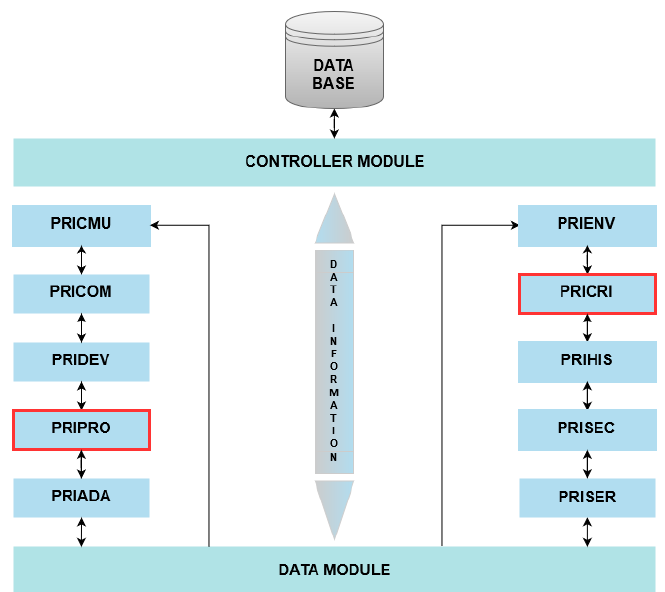
Figure 1. Privacy manager model. Adapted from UBIPRI (2015)